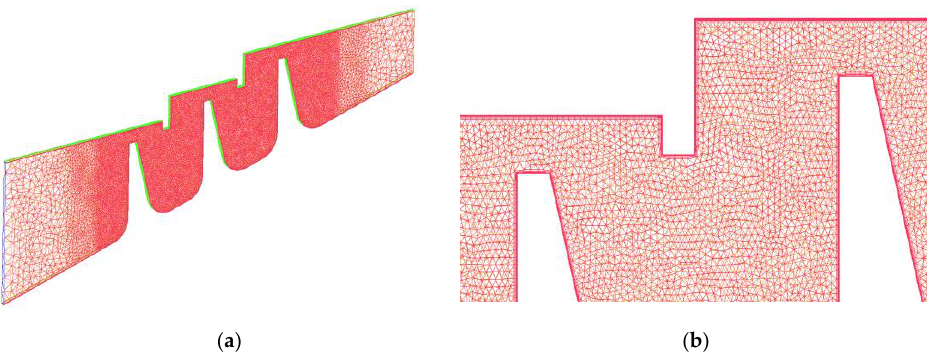
Figure 3. Example of the computational domain and meshes (S/H = 0.6). ( a ) Entire domain. ( b ) Enlarged view of the rib & clearance area.